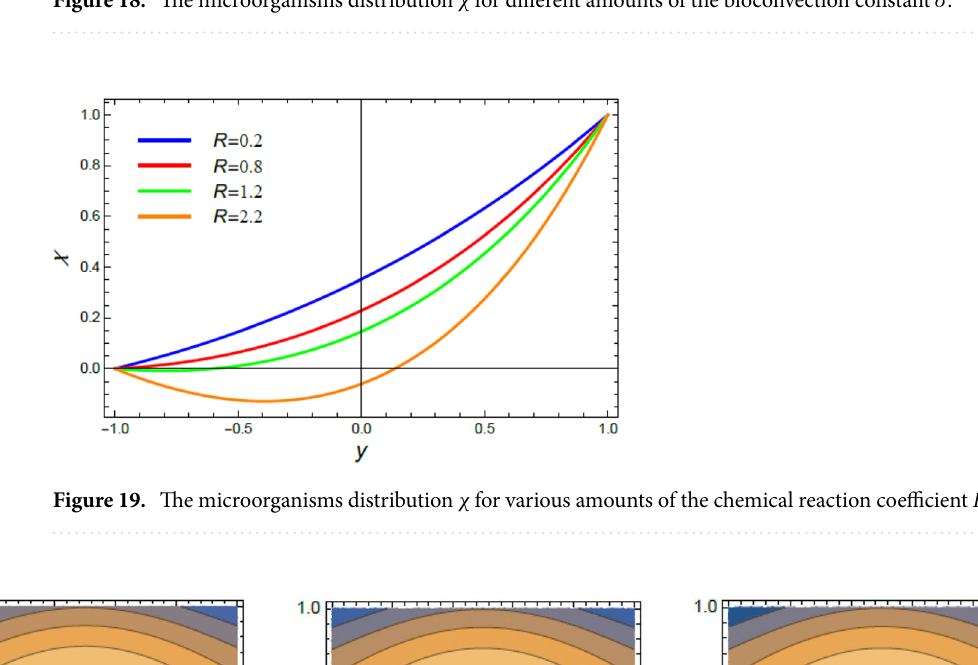
Figure 18. The microorganisms distribution χ for different amounts of the bioconvection constant σ .